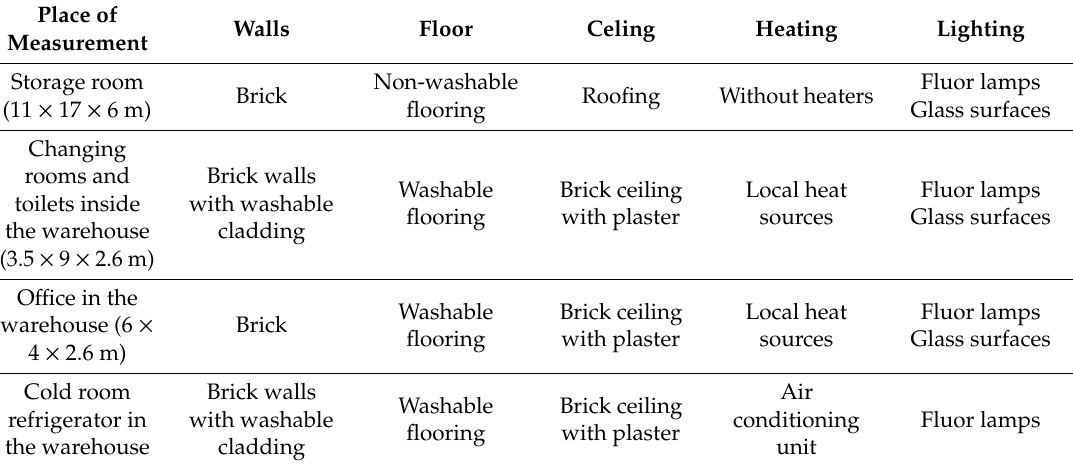
Table 1. Characteristics of the premises—overview.